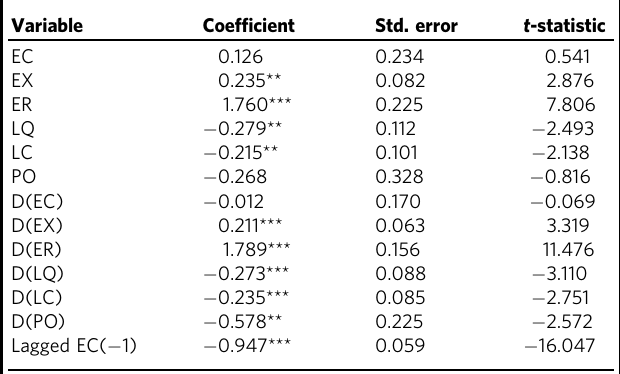
Table 8 VECM estimates analysis results (China).